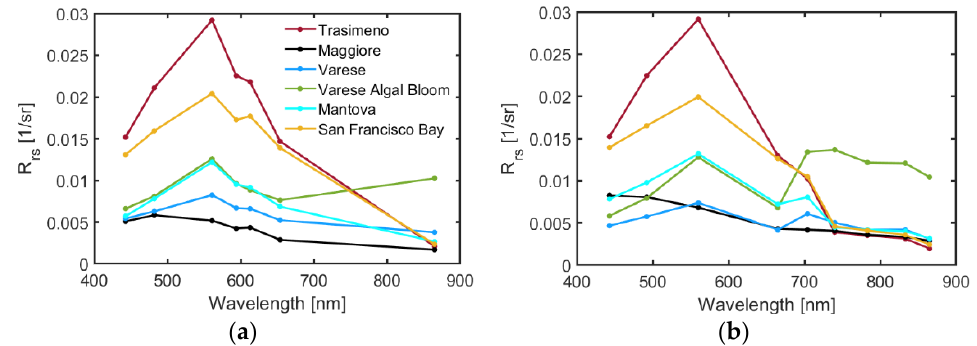
Figure 7. Remote sensing reflectance ( R rs ) spectra derived from DSF atmospheric correction over different case studies using ( a ) Landsat-9 and ( b ) Sentinel-2 imagery.